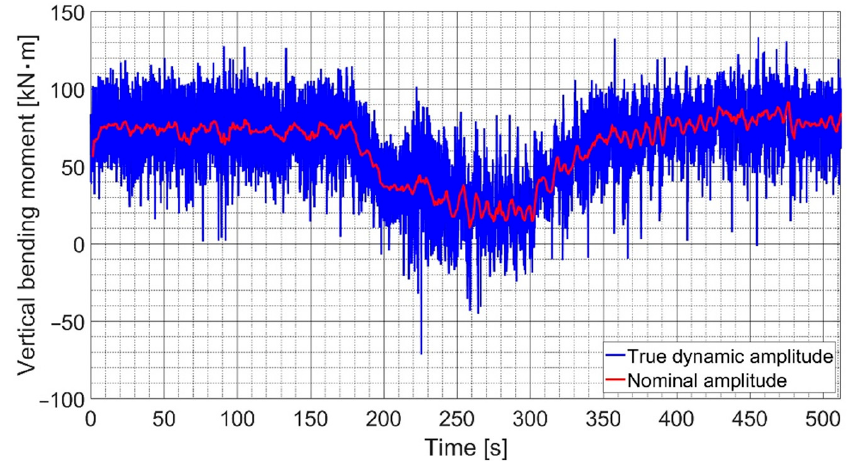
Figure 9. True dynamic bending moment in the vertical direction during rapid port turn.